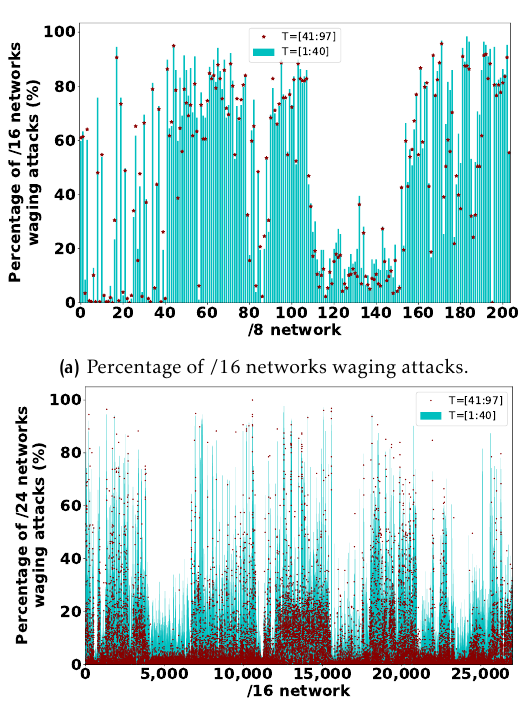
| , where the x -axis represents time (unit: day) and the y -axis represents | X Figure 3. Time series | X [ r ] (97)